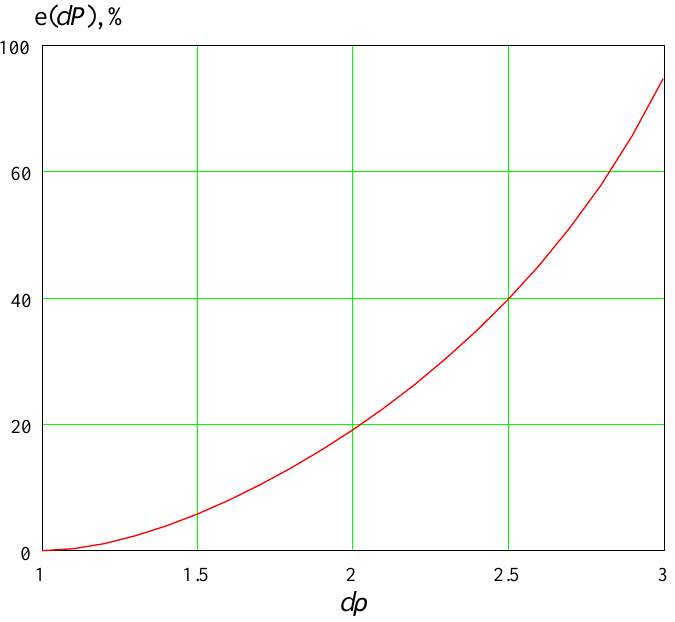
Figure 8. Dependence of efficiency on network heterogeneity .